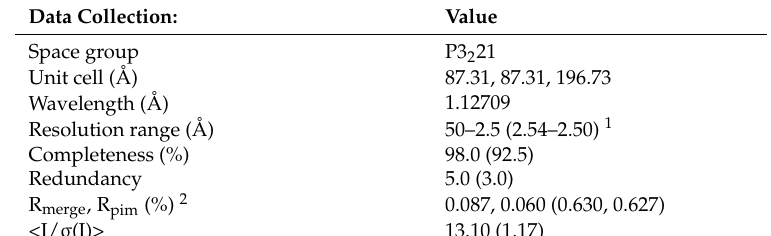
Table 2. X-ray data collection parameters and structure refinement statistics. Table 2. X ‐ ray data collection parameters and structure refinement statistics.